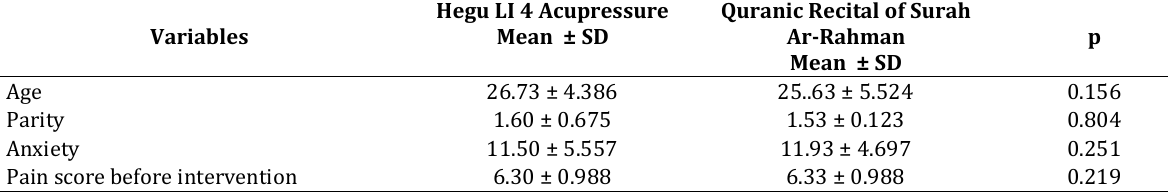
Table 1. Respondents’ Demographics and Characteristics